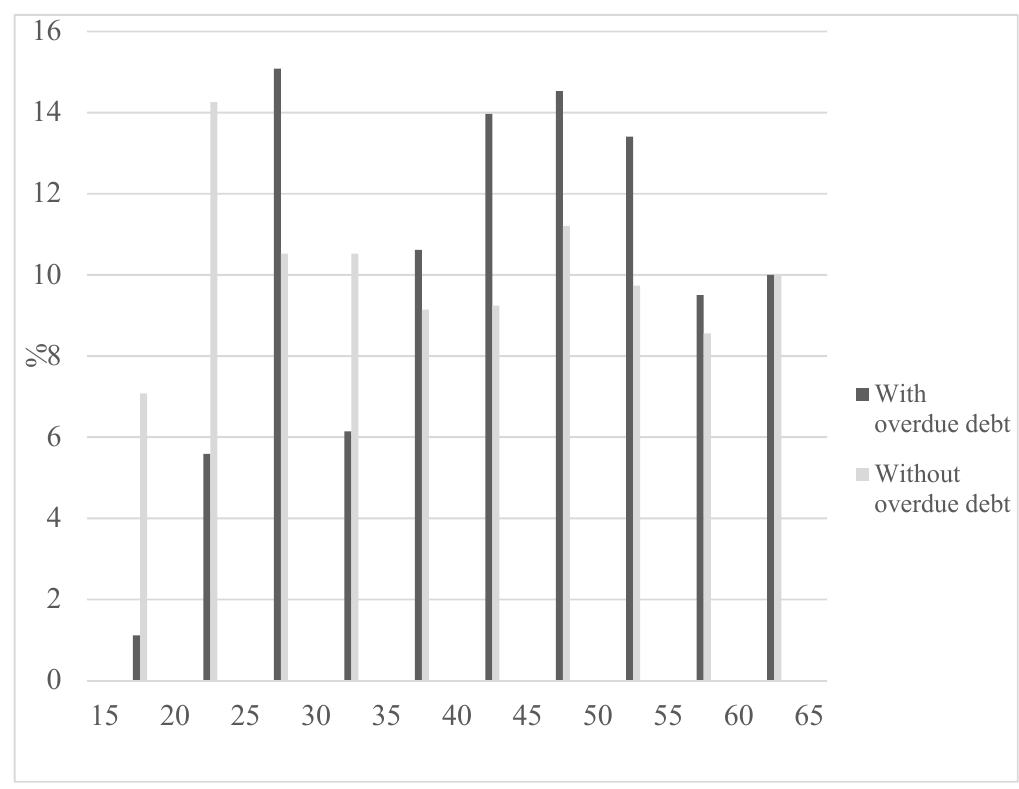
Figure 1. Distributions of age in the subsamples of individuals with and without overdue debts. Source: Questionnaire- based survey, small settlements of BAZ County, Hungary, 2019.